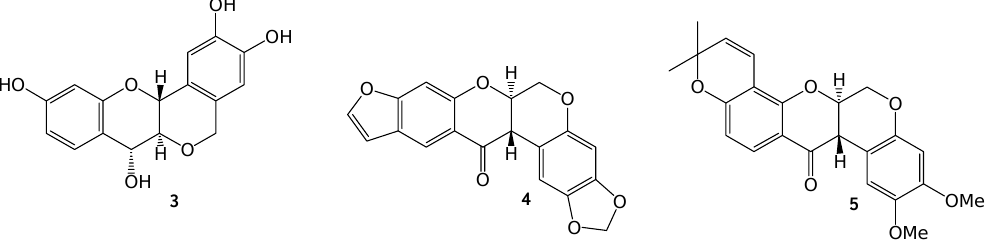
Figure 1. Structure of peltogynol and the naturally occurring